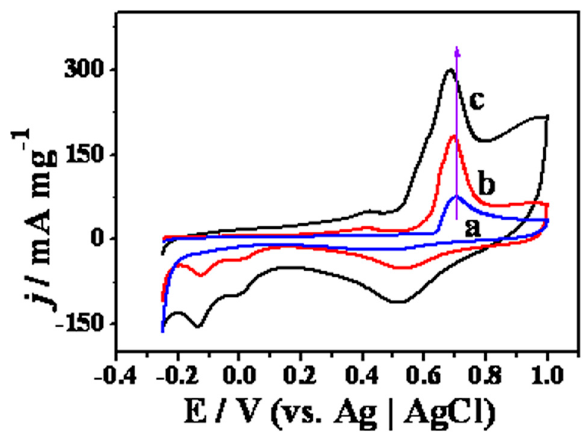
Figure 11. CO ‐ stripping voltammograms of Pt/C ‐ JM (a), Pt/GNs (b), and Pt ‐ Ag/GNs (c) in 0.5 M H 2 SO 4 ; Figure 11. CO-stripping voltammograms of Pt/C-JM (a), Pt/GNs (b), and Pt-Ag/GNs (c) in scan rate: 100 mV ∙ s − 1 . 0.5 M H 2 SO 4 ; scan rate: 100 mV · s − 1